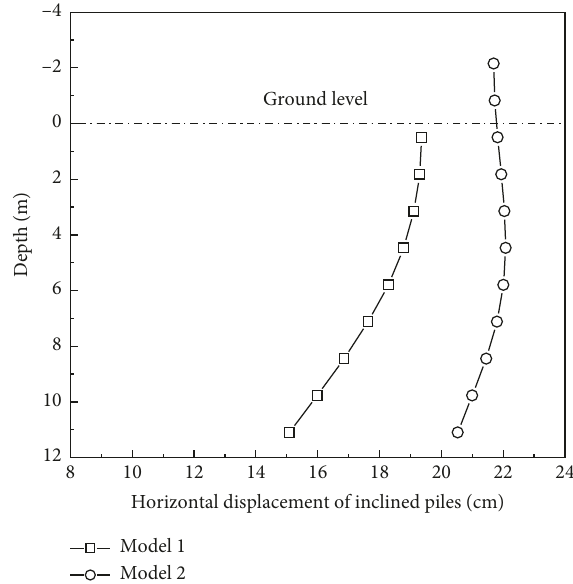
Figure 19: Contrastive analysis of bending moment of inclined piles.